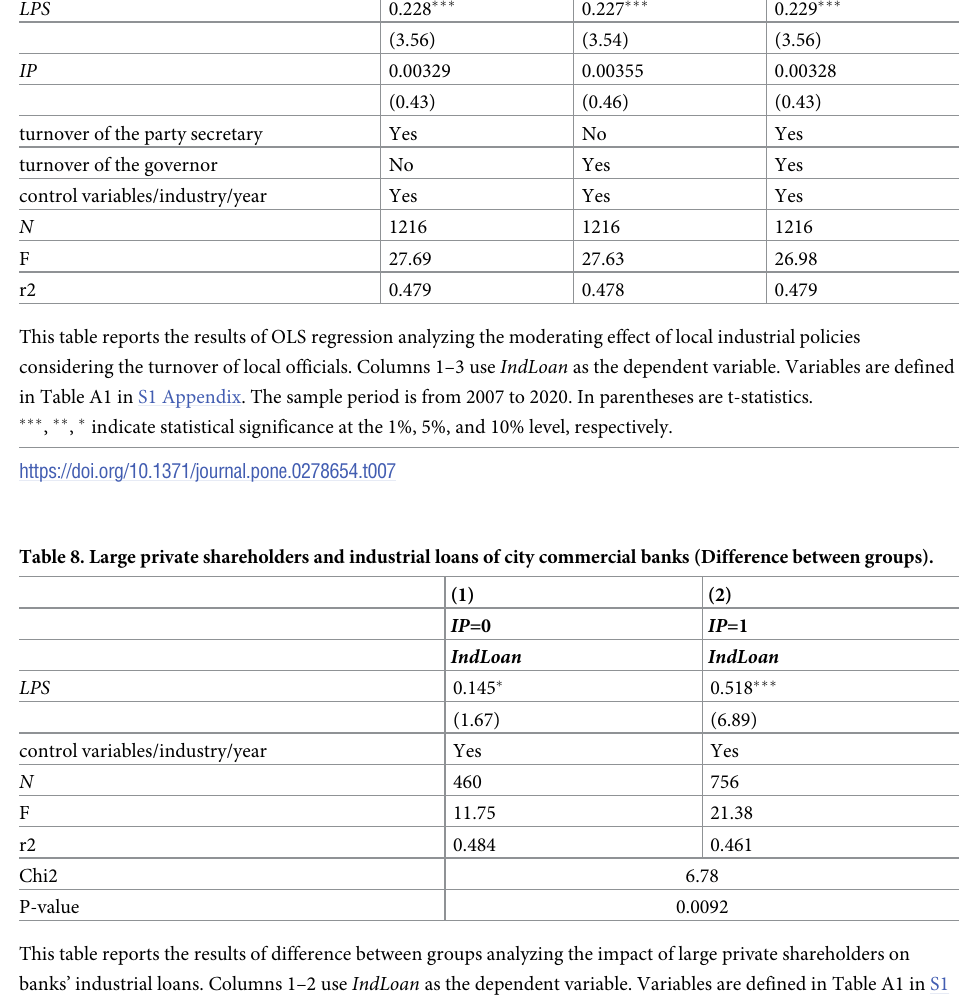
This table reports the results of difference between groups analyzing the impact of large private shareholders on banks’ industrial loans. Columns 1–2 use IndLoan as the dependent variable. Variables are defined in Table A1 in S1 Appendix. The sample period is from 2007 to 2020. In parentheses are t-statistics. ���